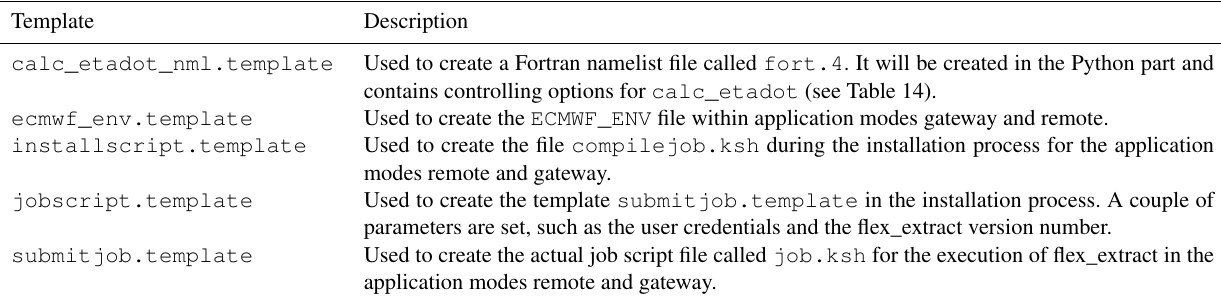
Table 10. Overview of templates used in flex_extract. They are stored in the Templates directory. Template